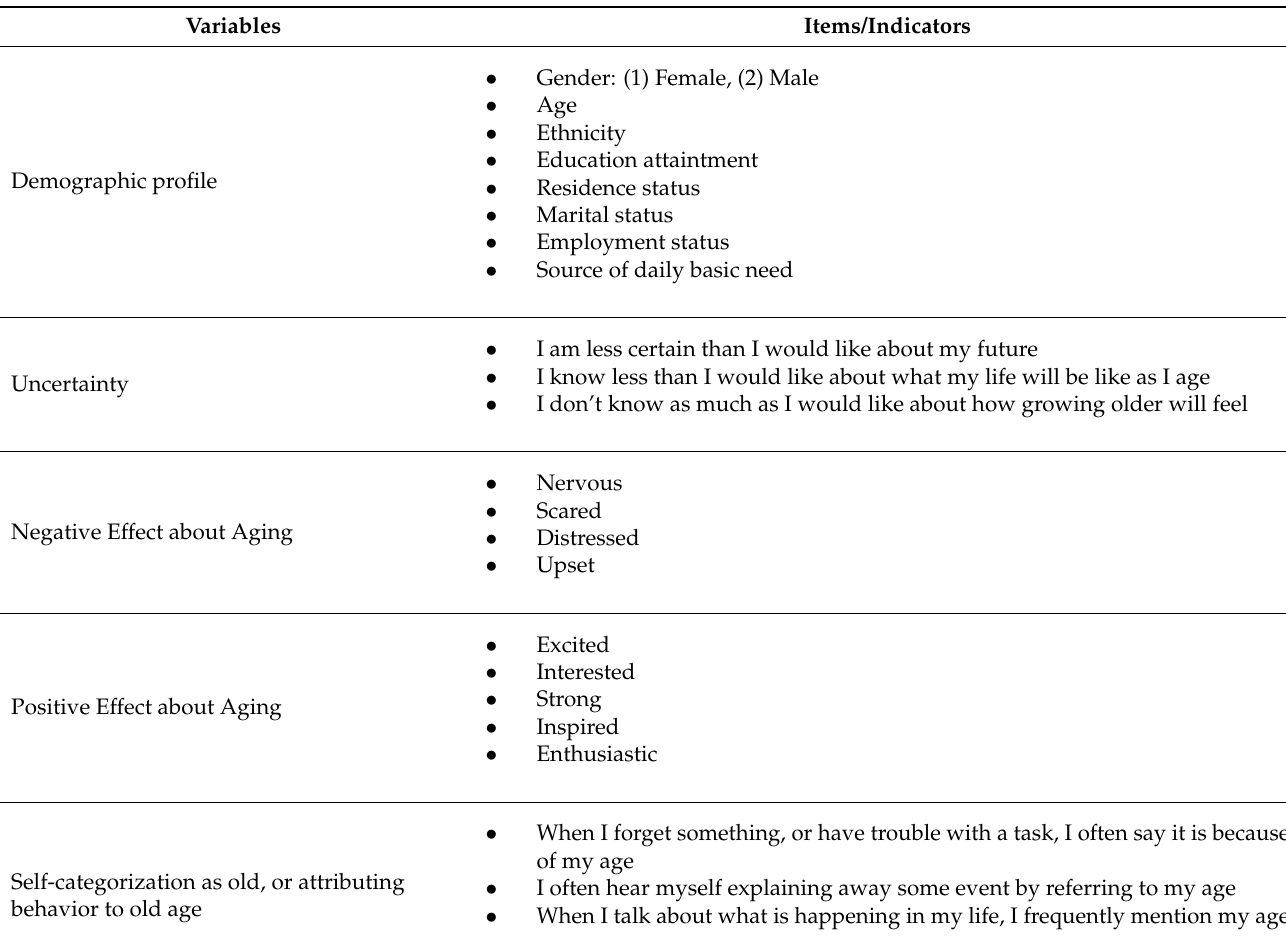
Table A7. Items of Variables from Communication Ecology Models of Successful